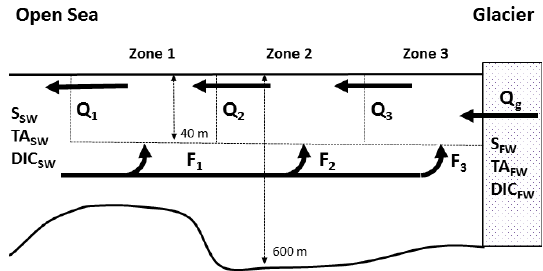
Figure 2. Conceptual model of the fjord system from glacier (right) to open sea (left). The fjord is divided into three zones (according to the zones indicated on the overview